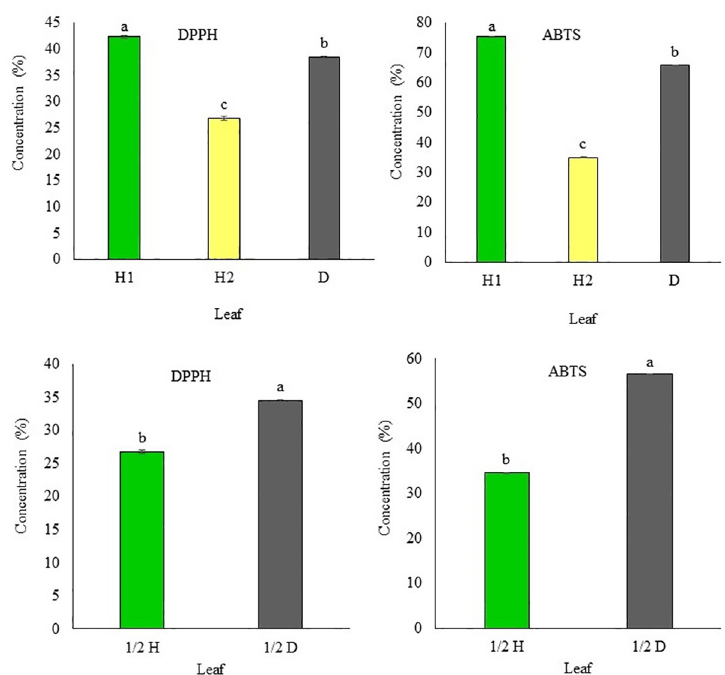
Fig 4. Antioxidant activity in H1: asymptomatic leaf (early stage); H2: asymptomatic leaf (collected during the infection period); and D: symptomatic leaf; 1/2 H: asymptomatic part of infected leaf; 1/2 D: symptomatic part of the leaf infected with Plurivorosphaerella nawae . Different letters indicate that the means are significantly different at 95% confidence level.